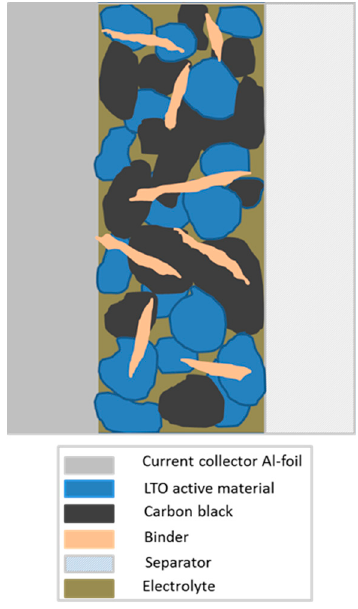
Figure 2. Cross-section scheme of electrode setup.